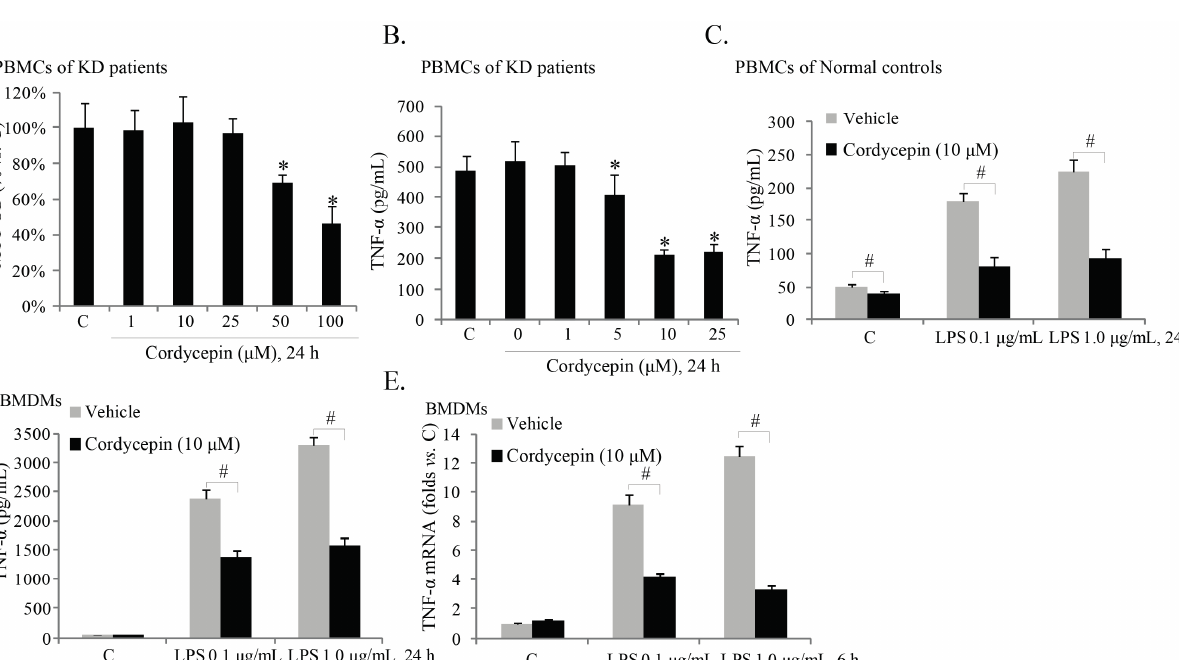
Figure 2. Cordycepin inhibits TNF α production in ex vivo cultured peripheral blood mononuclear cells (PBMCs) of KD (Kawasaki disease) patients. The ex vivo cultured PBMCs of acute KD patients were either left untreated (“C”) or treated with indicated concentrations of cordycepin for 24 h; cell viability was analyzed by MTT assay ( A ); TNF α in culture supernatant was measured with the ELISA kit ( B ); The ex vivo cultured PBMCs from healthy controls or the primary BMDMs (bone marrow derived macrophages) were stimulated with LPS (0.1 or 1.0 μ g/mL) in the presence or absence of cordycepin (10 μ M). TNF α content in culture supernatant was measured with the ELISA kit 24 h after treatment ( C , D ); and TNF α mRNA expression was examined 6 h after stimulation ( E , for BMDMs). The results presented are representative of three independent experiments. The values are expressed as the means ± SD. * p < 0.05 compared with “C” group ( A , B